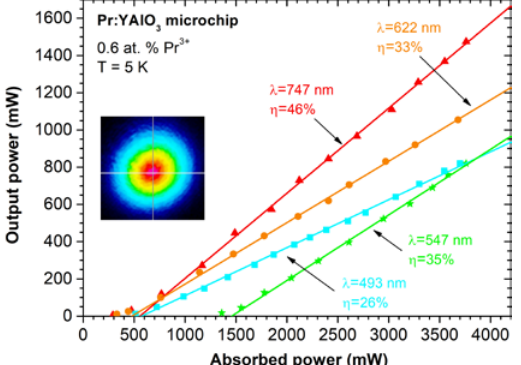
Fig. 2. Maximal output powers of Pr:YAP microchip lasers designed for generation in near-infrared, orange, green, and cyan-blue laser transitions as a function of crystal